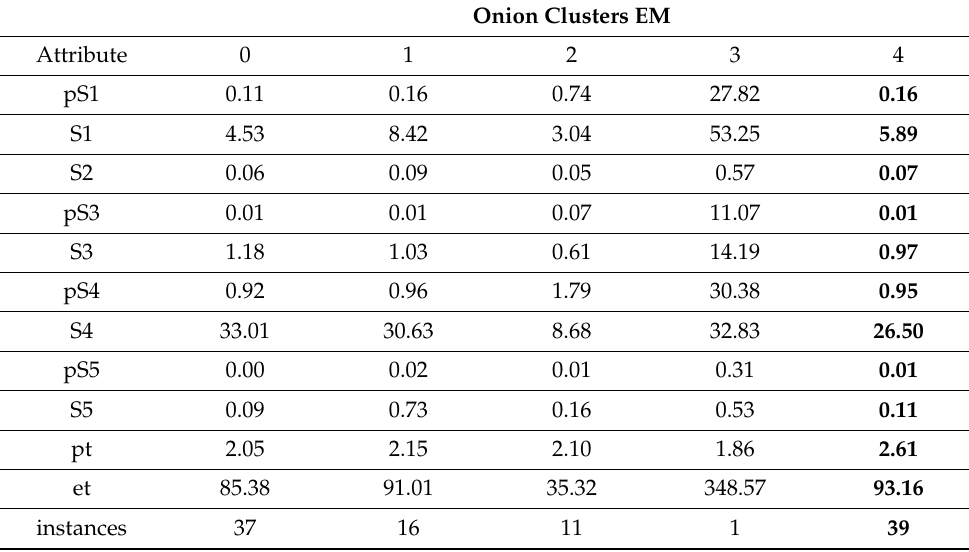
Table 5. The EM clusterization results of the mean values of the parameters of the chosen stages. Onion Clusters EM